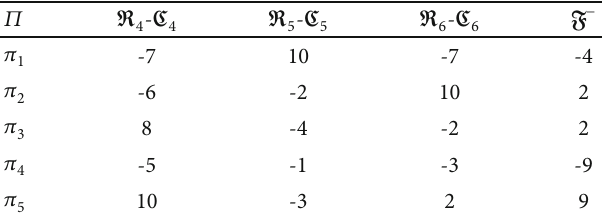
Table 20: The fi nal negative score table.